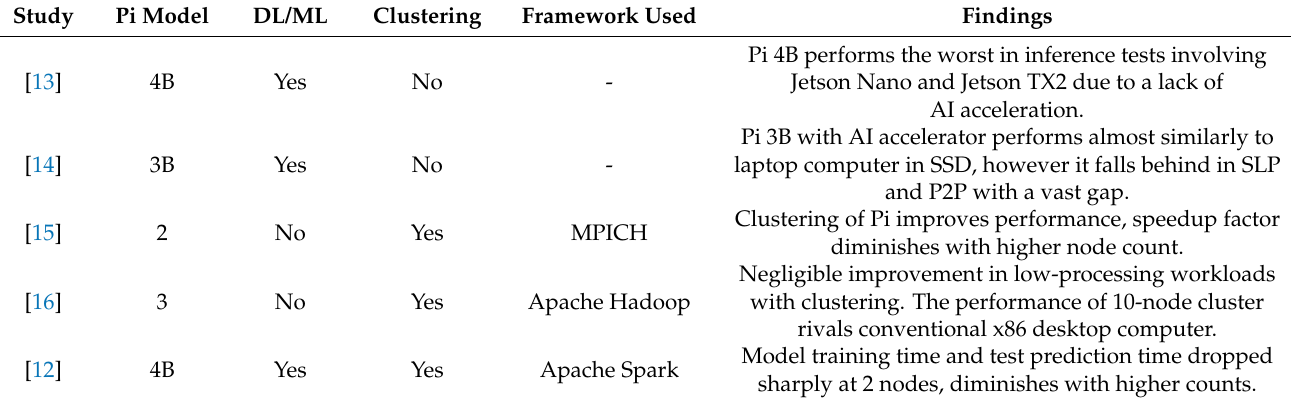
Table 1. Summary of research coverage from previous works regarding Pi DL inference and dis- tributed Pi